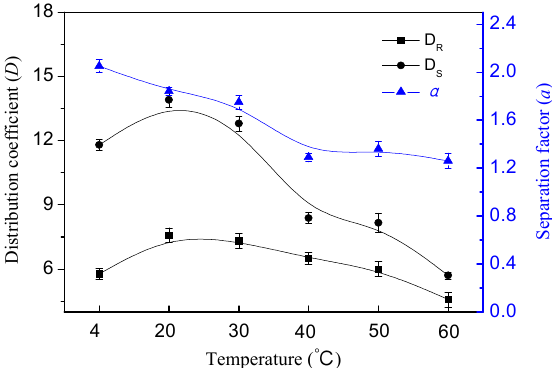
Figure 8. Effect of temperature on the chiral extraction of phenylalanine enantiomers. The extraction conditions were as follows: 30 wt% [Ch][L-Pro], 7.8 wt% K 3 PO 4 , 40 mmol/L HP- β -CD, 15 mg/mL phenylalanine, and system pH 8.0.